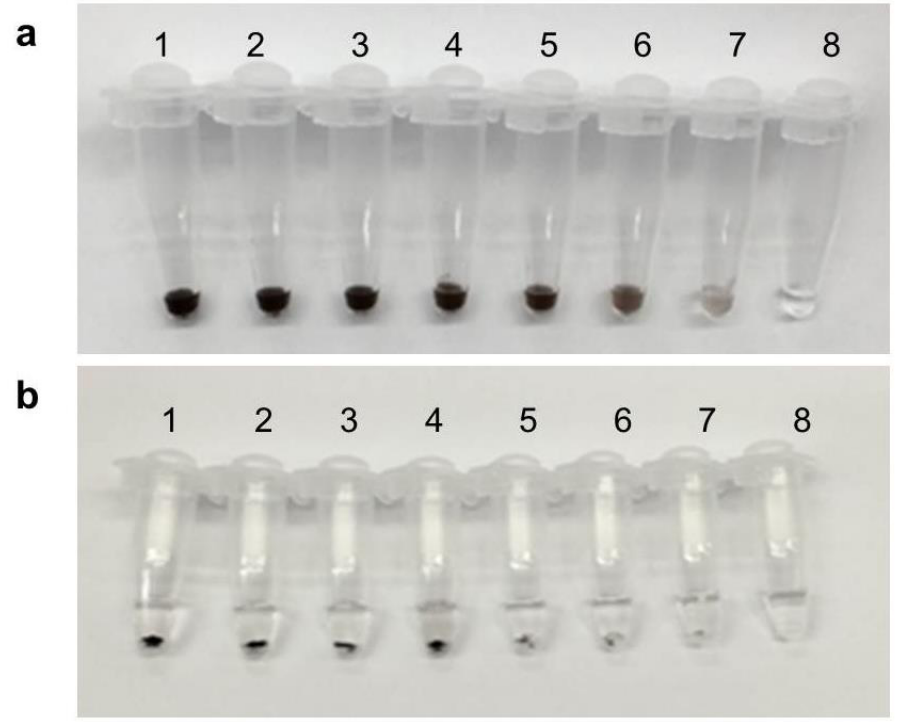
Figure 4. Optimization of magnetic beads input. ( a ) Before the agglomeration reaction; ( b ) After the agglomeration reaction. Numbers 1~8 represent the amount of magnetic beads added: 6000 ng, 4000 ng, 2000 ng, 1000 ng, 500 ng, 250 ng and 100 ng. Position 8 is a negative control.